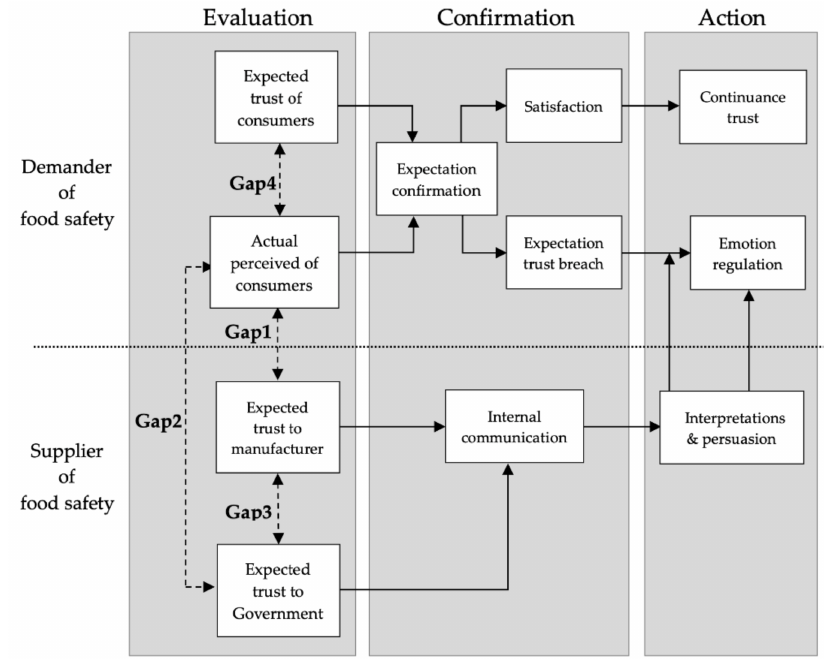
Figure 1. Food safety gap in the Evaluation-Confirmation-Action (ECA) model: A conceptual model that defined the consumer’s food safety gap and psychological